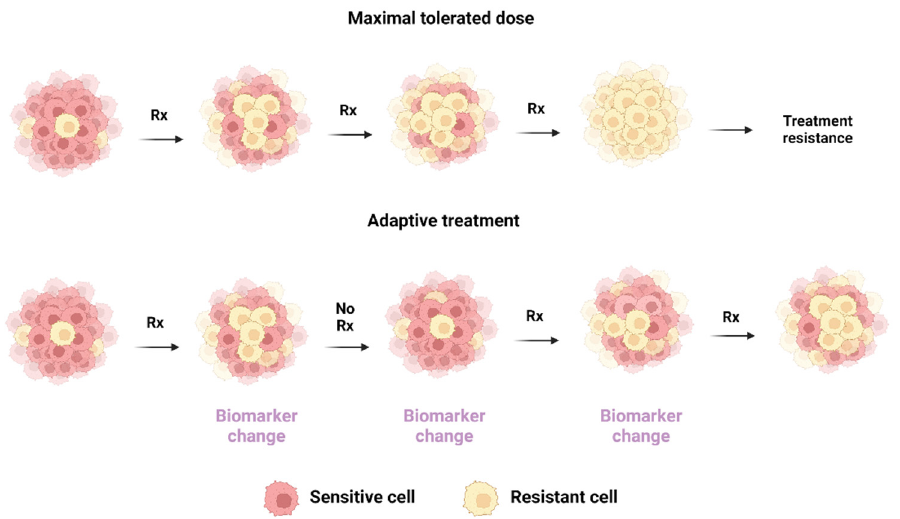
Figure 3. Comparison of maximally tolerated dose and adaptive treatment strategies utilizing liquid biopsy. Rx, treatment.